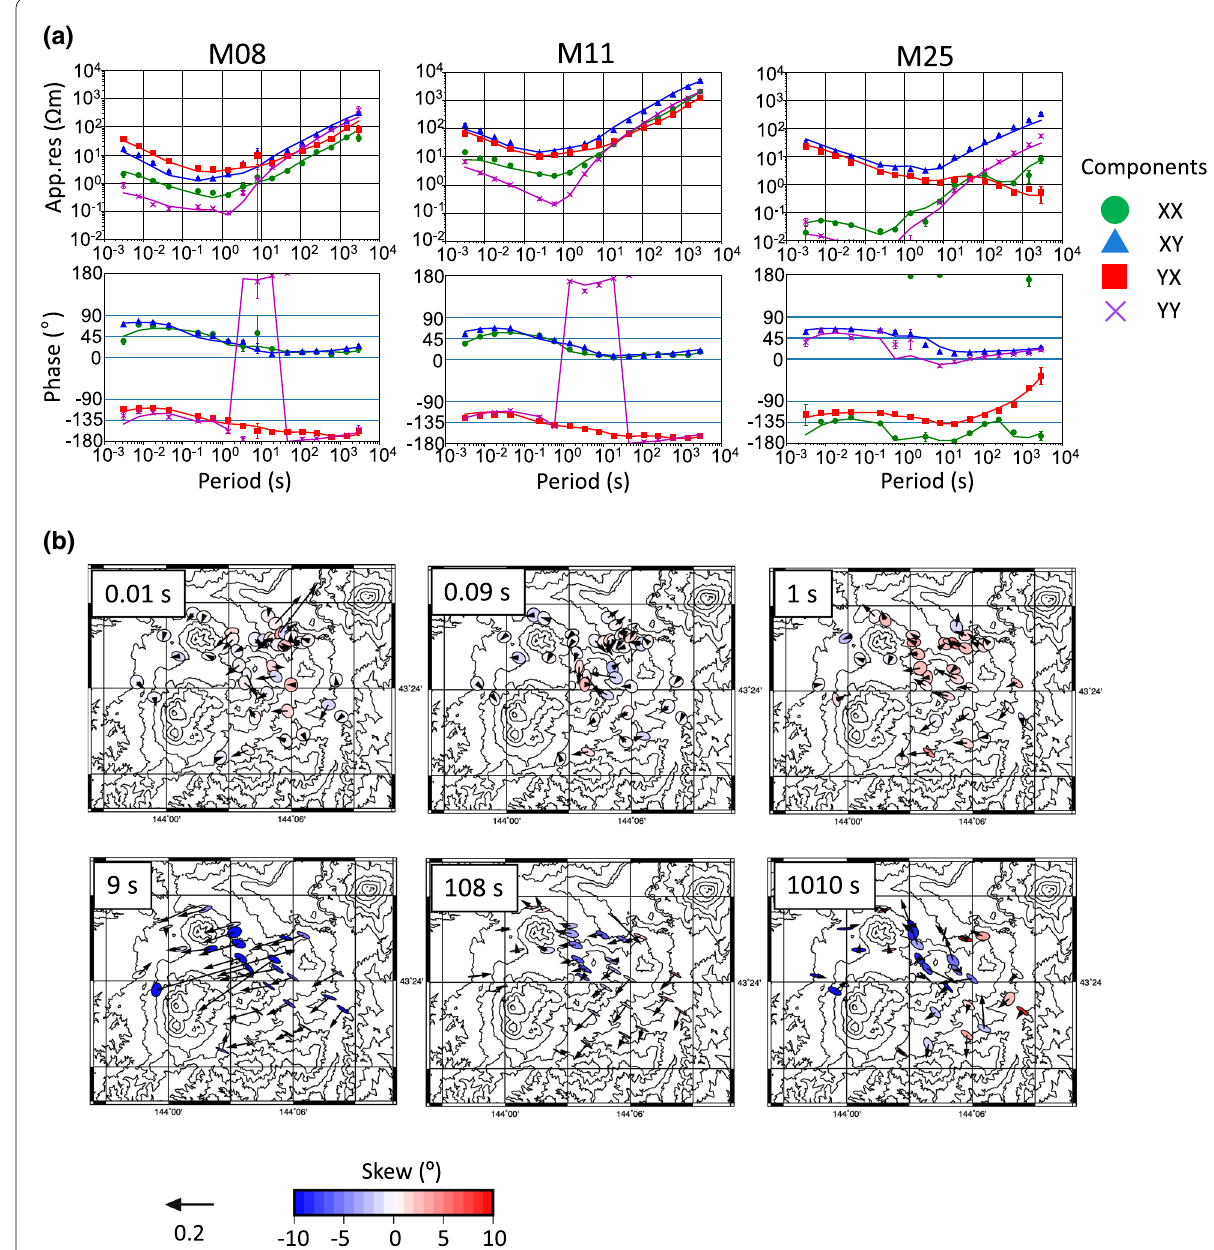
Fig. 2 a Apparent resistivities and phases at selected sites. The dots indicate the observed data, while the solid lines represent model response data from the optimal resistivity model shown in Fig. 3. b Induction vectors and the phase tensor ellipses. Ellipses were normalized by their major